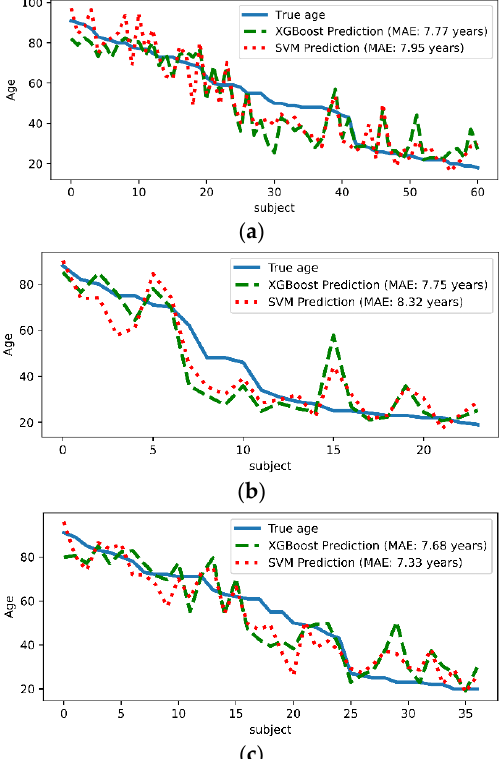
Brain Sci. 2022 , 12 , x FOR PEER REVIEW 10 of 21